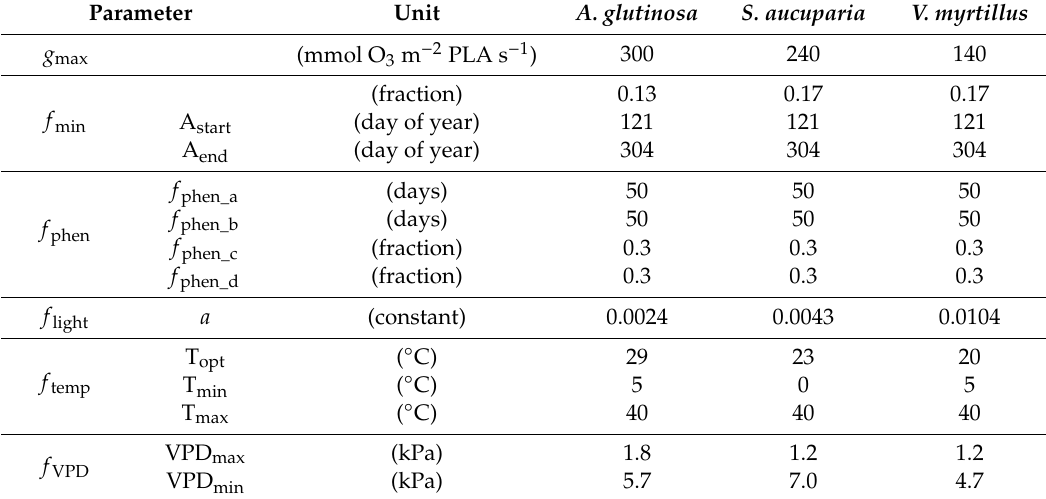
Table 2. Summary of parameters in the DO3SE stomatal conductance model for Alnus glutinosa , Sorbus aucuparia, and Vaccinium myrtillus .